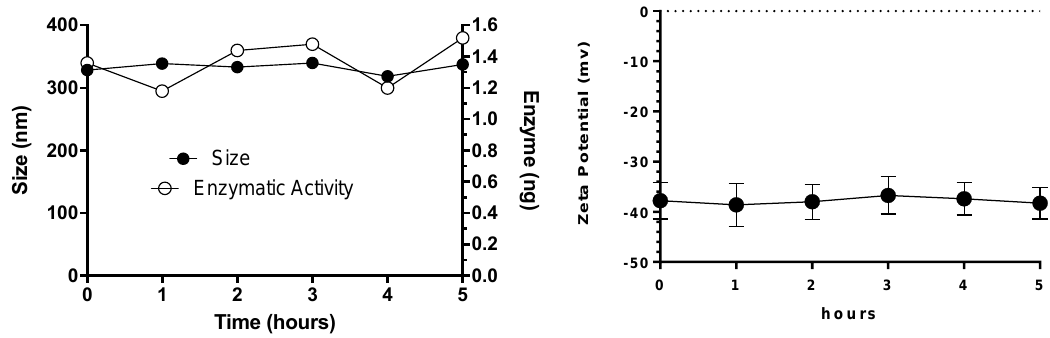
ff ect of plasma on elosulfase alfa-NLC stability (size and ζ Figure 4. Effect of plasma on elosulfase alfa-NLC stability (size and ζ potential). Figure 4. E